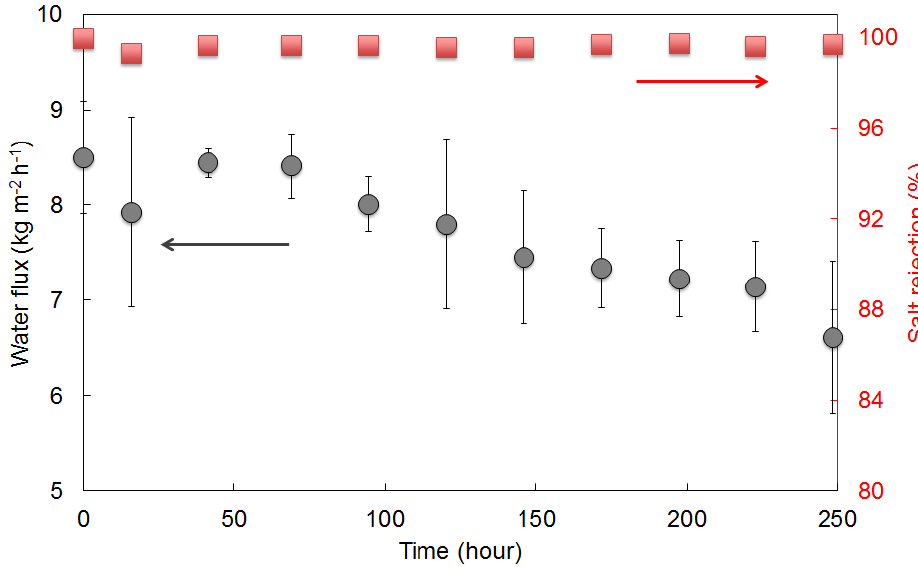
Figure 7. Water fluxes and salt rejection of the membrane as a function of exposure time over 250 h in 3.5 wt % feed saline solution at 22